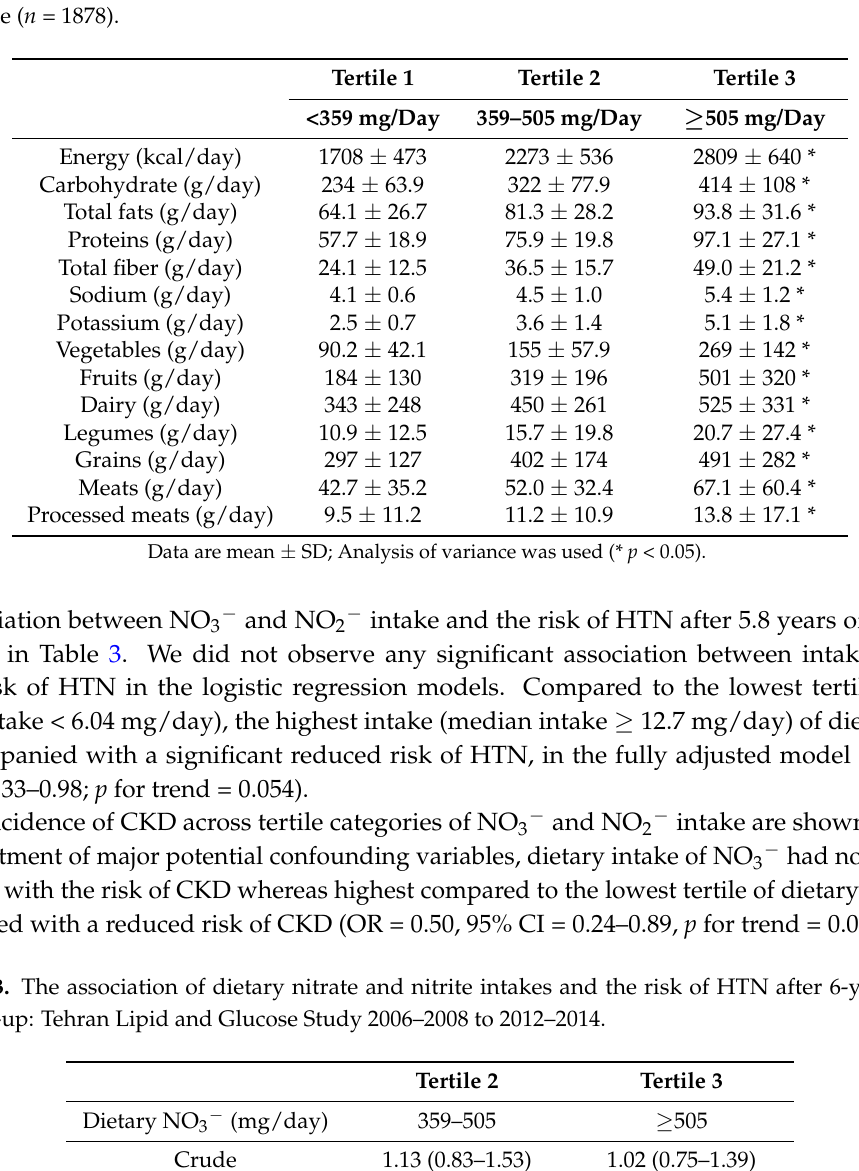
Table 2. Dietary intakes of across tertile categories of dietary nitrate intakes in HTN-free subjects at baseline ( n =